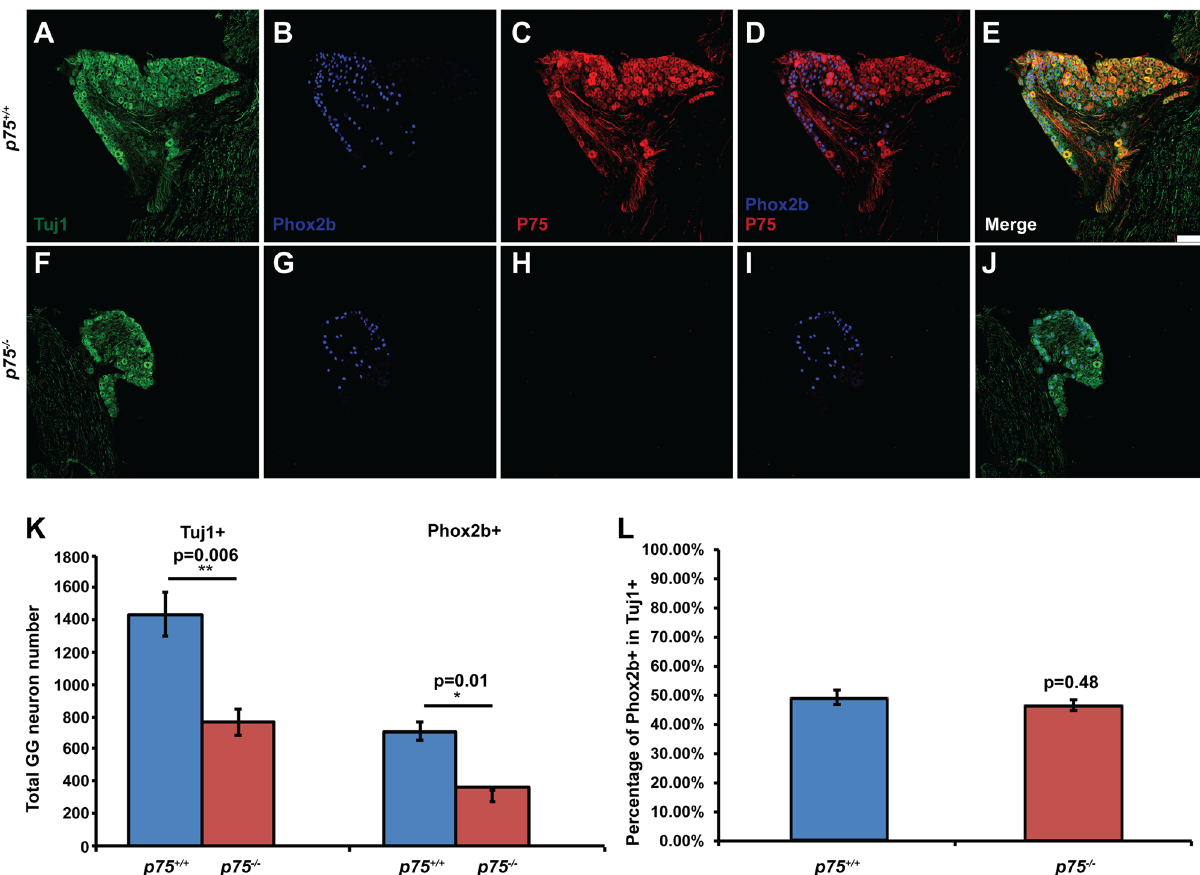
Figure 1. Both oral sensory and pinna-projecting somatosensory neurons are lost in the geniculate ganglia of p75 − / − mice. Geniculate ganglia from p75 + / + and p75 − / − mice were fixed and immunolabeled for Tuj1 ( A and F , green, a marker of all neurons), Phox2b ( B and G , blue, a marker of oral sensory neurons) and p75 ( C and H , red). p75 was highly expressed in both Phox2b + and Tuj1 + /Phox2b-neurons in p75 + / + mice ( D , E ). No p75 immunolabel was observed in either Phox2b + or Tuj1 + neurons in p75 − / − mice ( I , J ), confirming p75 deletion. ( K ) The total number of Tuj1 + and Phox2B + neurons were quantified and displayed as a bar graph. The total numbers of geniculate ganglion neurons (Tuj1 +) were significantly reduced in p75 − / − mice (1434 ± 134) compared to p75 + / + mice (764 ± 54; p = 0.006), and the oral sensory (Phox2b +) neurons have a similar reduction in p75 − / − mice (708 ± 81) compared to p75 + / + mice (357 ± 32; p = 0.01). ( L ) The percentage of Phox2b + neurons was unchanged between p75 + / + and p75 − / − mice (p = 0.48), indicating both oral sensory and